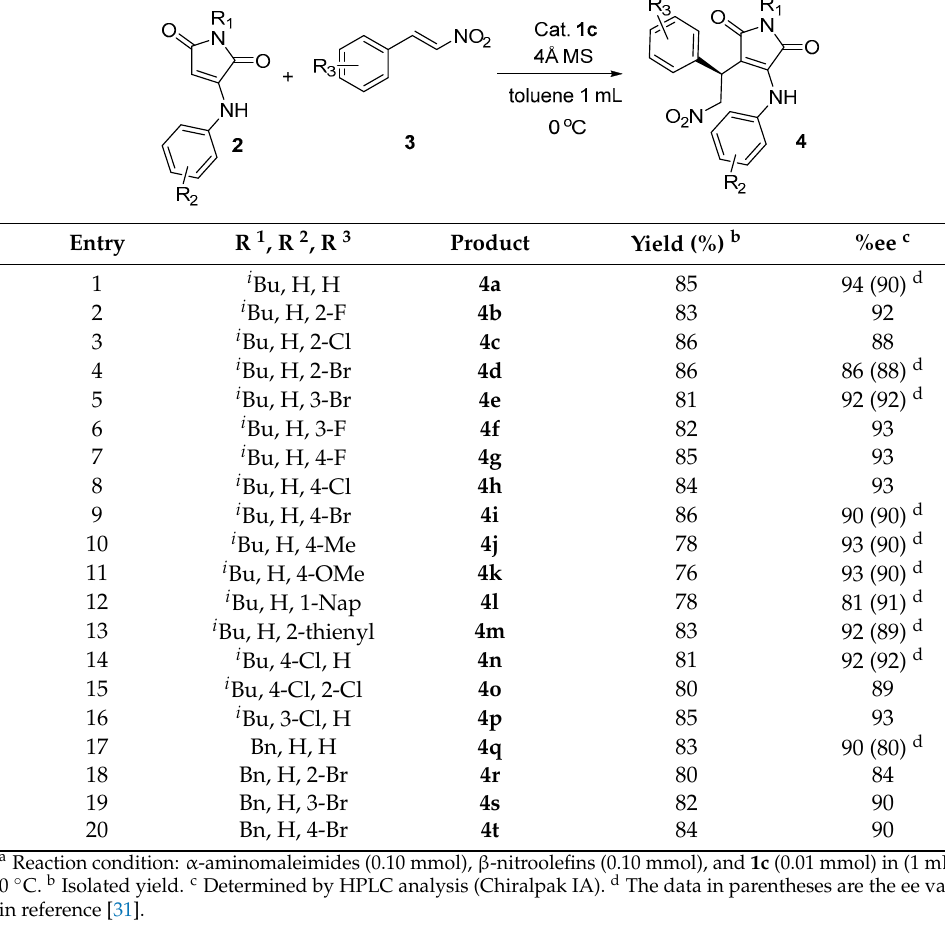
Table 3. Generality of the enantioselective Michael reaction of α -aminomaleimides with β -nitroolefins a .